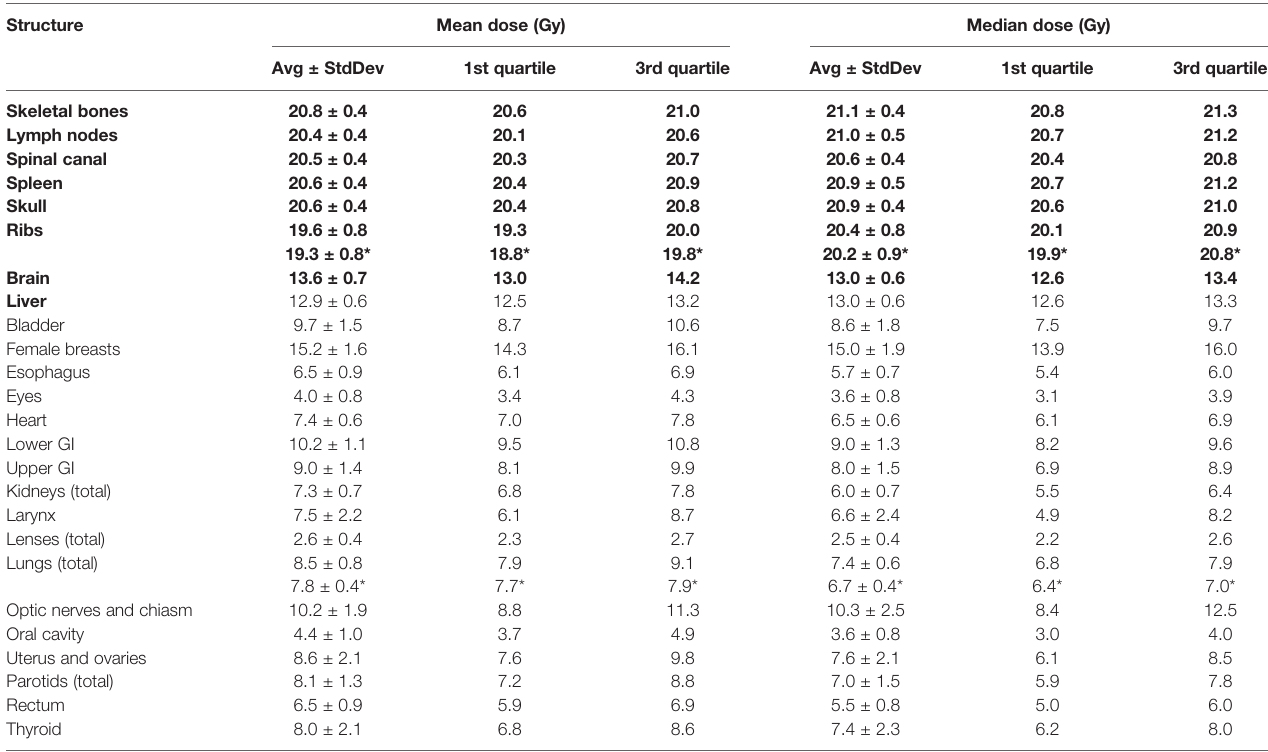
TABLE 4 | Statistics of mean dose and median dose (D50) for each structure with the 20-Gy cohort. Structure Mean dose (Gy) Median dose (Gy) Avg ± StdDev 1st quartile Skeletal